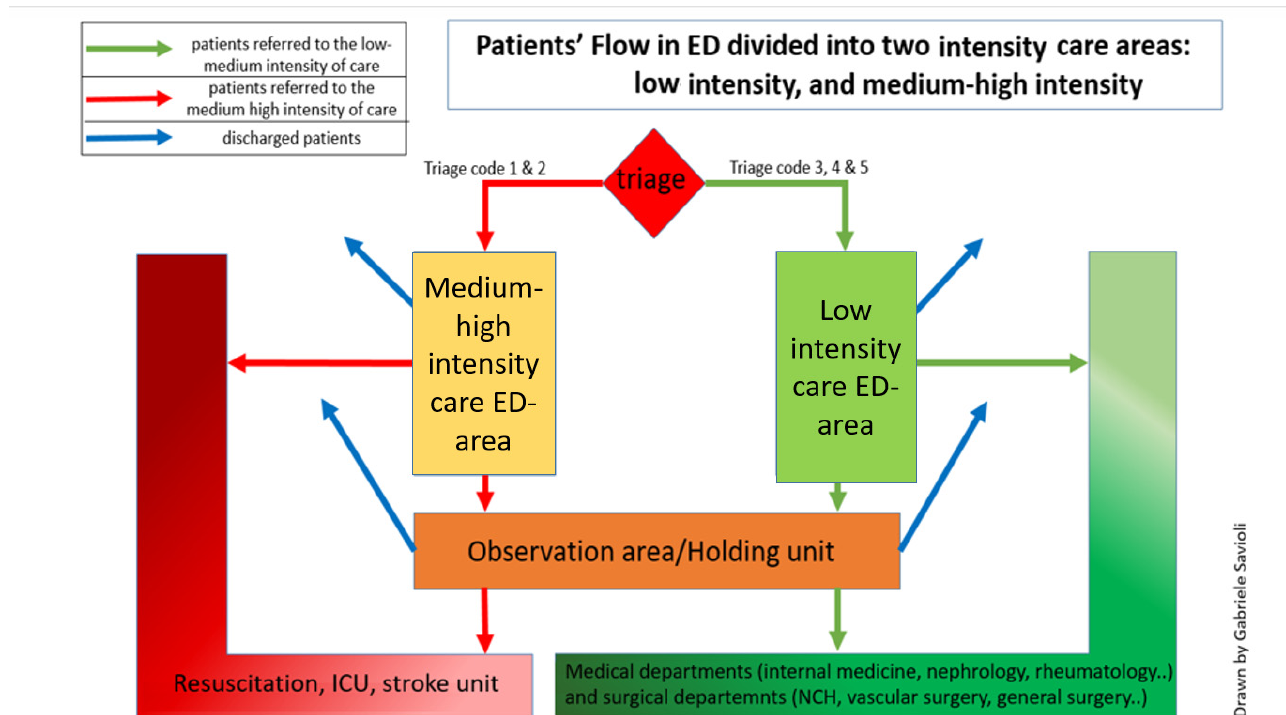
Figure 1. Our ED is divided into two areas according to care intensity. A medium-high-intensity area (shown on the right in the figure) includes a shock room for cases to be isolated and medium- high-intensity beds. Patients at high developmental risk and requiring high care intensity (codes 1 and 2) are routed here. In a second area, patients with low-intensity care are managed, and some patients with medium-intensity care (codes 3, 4, and 5) can be managed. The two areas are physically separated while remaining connected through two corridors so that low- and high- intensity patient fl ows do not cross. Patients can be sent to the observation unit—where patients are stabilized, monitored, and observed—from both areas. Our observation unit also functions as a holding unit from the observation unit; patients can be hospitalized, transferred to other hospitals, or discharged. Admission and discharge are directly possible from both areas.